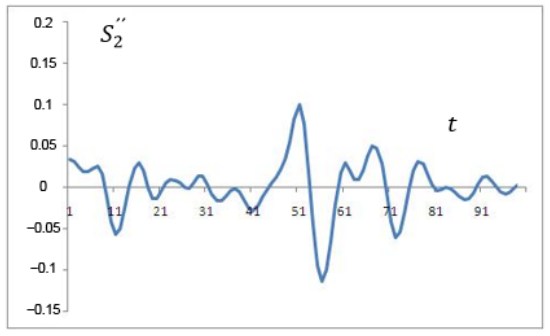
Figure 3. Summation in reverse order.